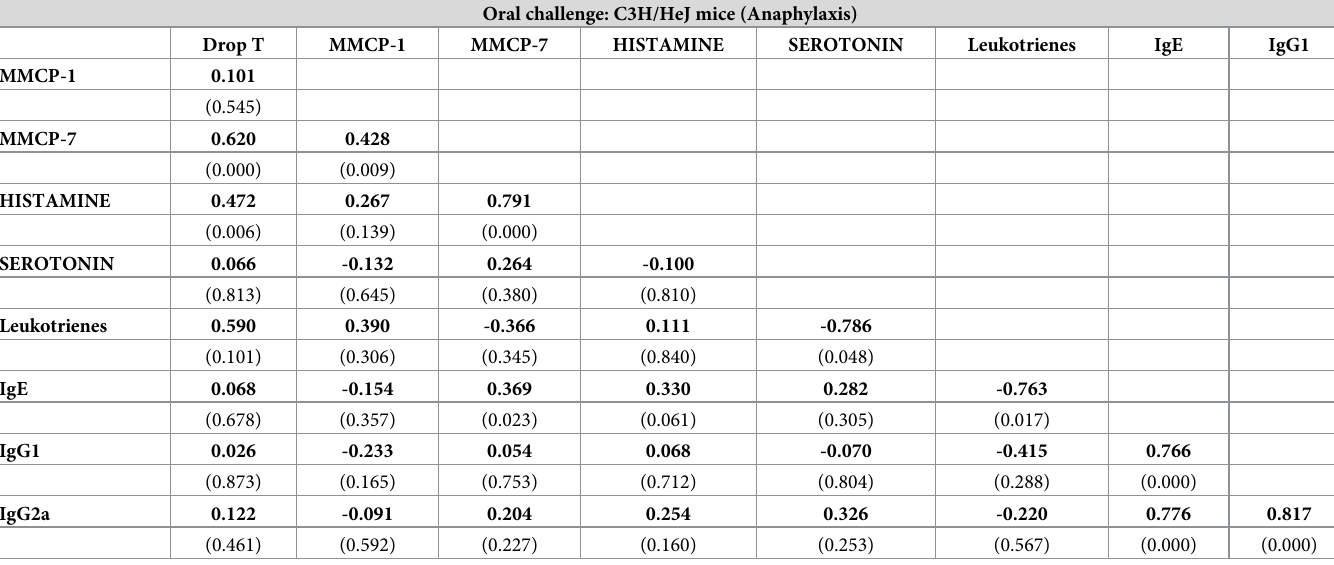
Bolded values indicate spearman correlation coefficient, values in brackets indicate p value. Drop T = drop in body